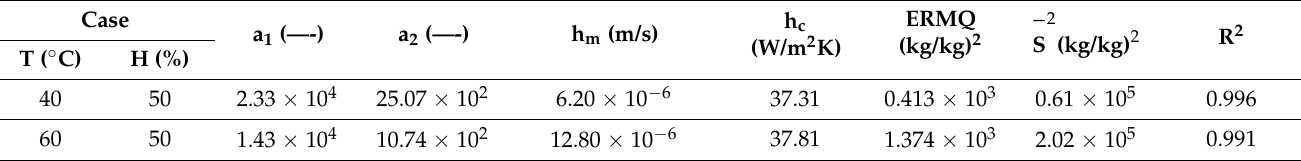
Table 2. Comparison between the liquid and vapor conductivity and residual error.